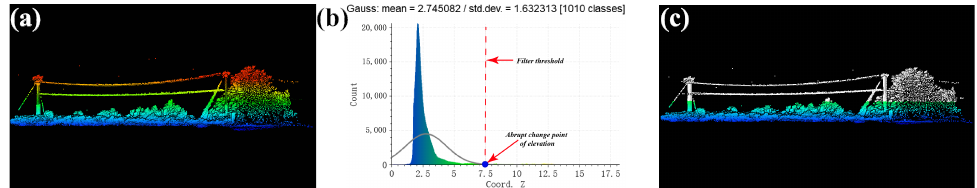
Figure 3. An overview of the elevation filtering process on raw point cloud data: ( a ) normalized point clouds; ( b ) elevation-point-figure maps; and ( c ) elevation filtering effects (white and